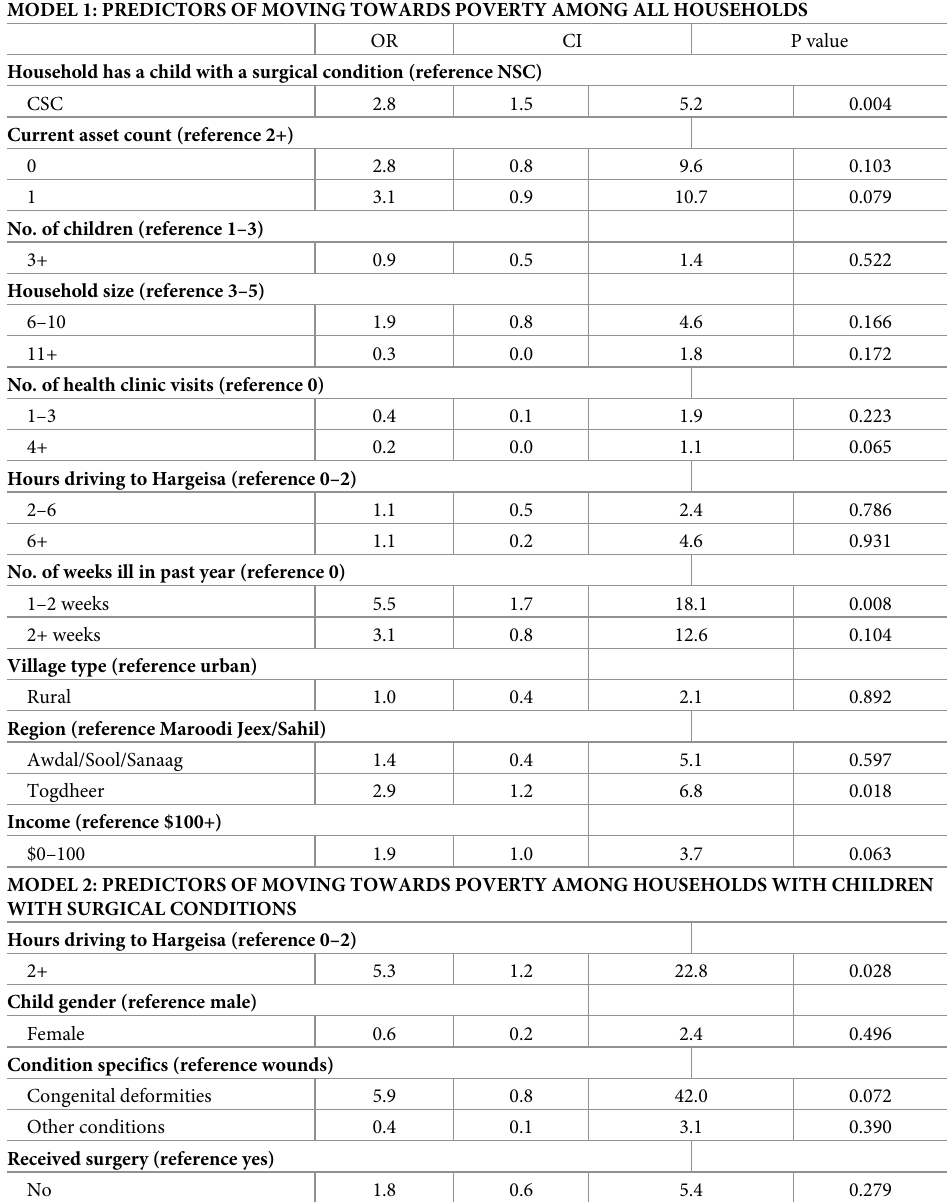
Table 5. Full list of covariates in multivariate models. MODEL 1: PREDICTORS OF MOVING TOWARDS POVERTY AMONG ALL HOUSEHOLDS OR CI